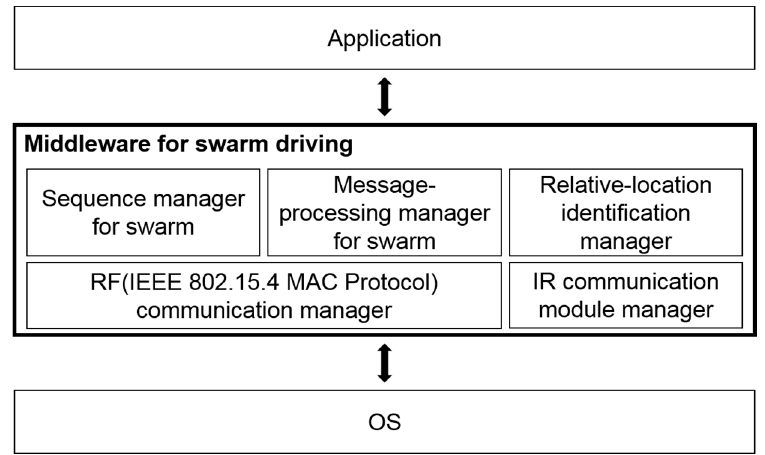
Figure 5. Middleware architecture for swarm-driving.